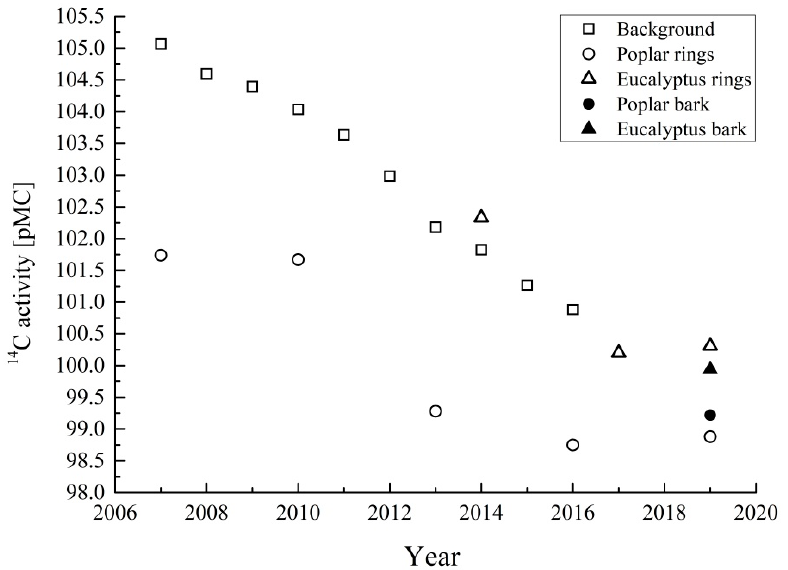
Figure 6. Comparison of Suqian poplar, Guigang eucalyptus and Northern Hemisphere atmospheric background in the period of 2007–2019.